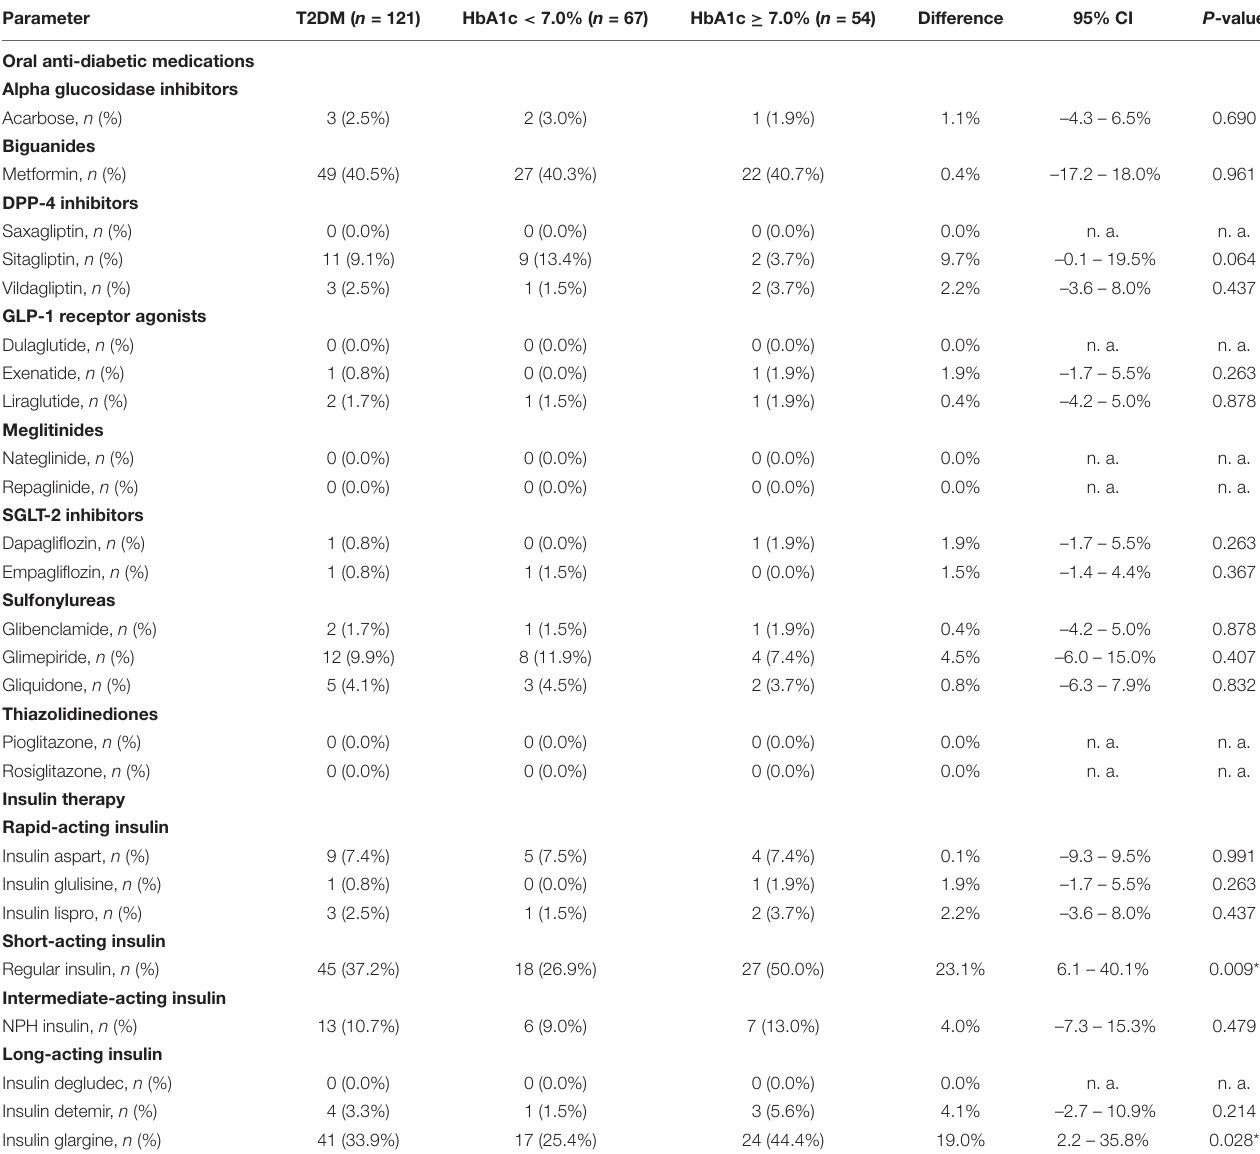
TABLE 5 | Overview of diabetes medications.